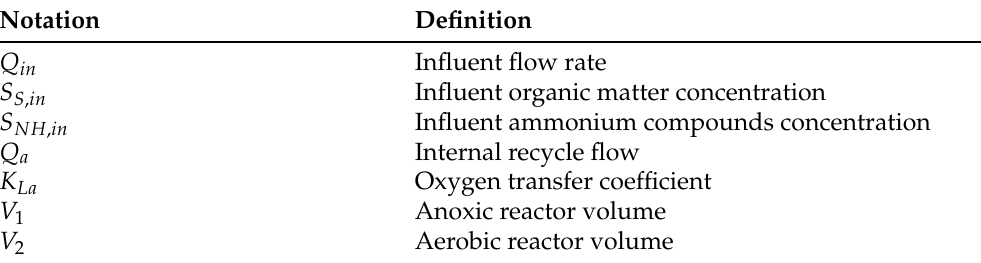
Table 2. Process characteristics.